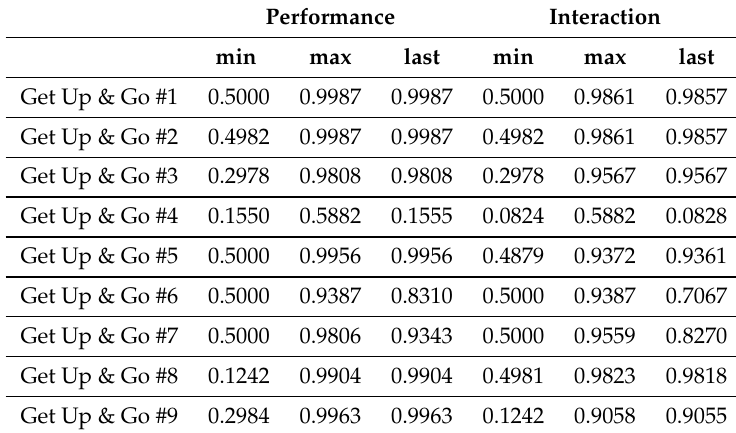
Table 6. Get Up & Go test results associated to the tests in Table 5 (see text for